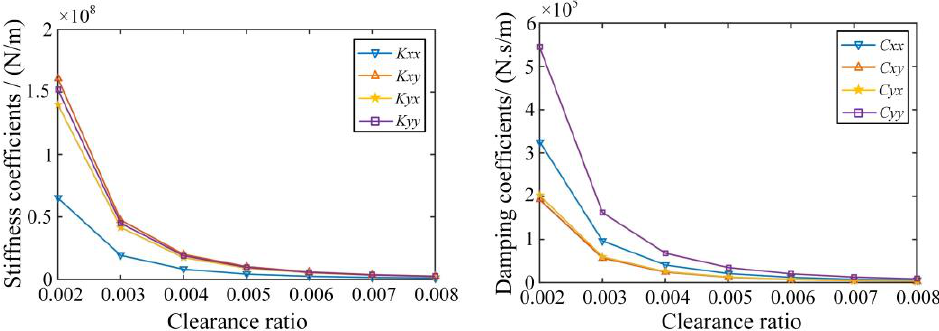
Figure 6. Variation tendencies of the dynamic coefficients for different sliding bearing lengths L b .